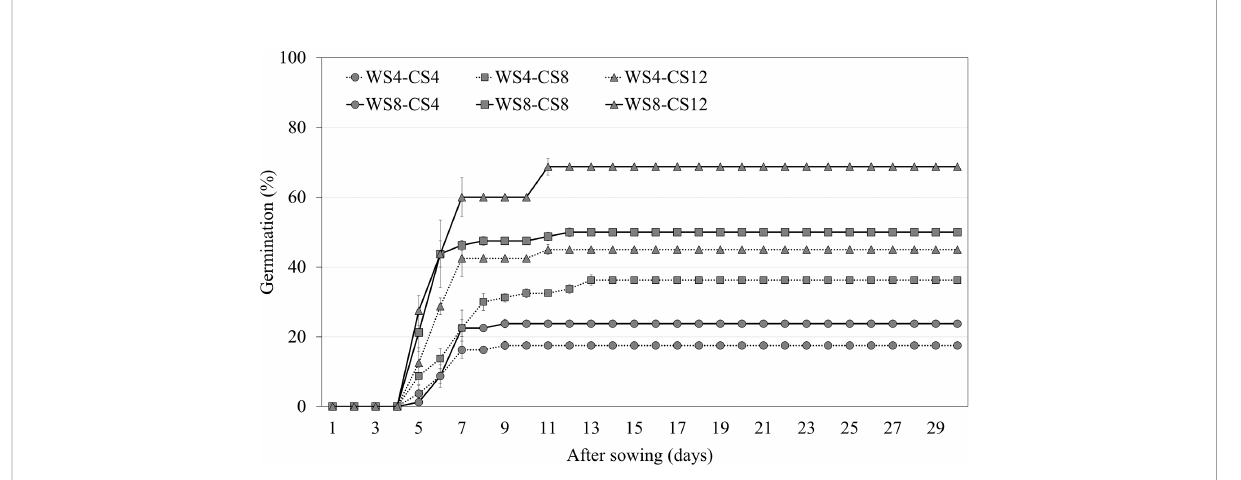
FIGURE 5 Germination of non-scari fi ed Amsonia elliptica seeds at 25/15°C after combined strati fi cation for indicated periods. WS, warm strati fi cation (15/ 10°C, 16/8 h); CS, cold (4°C). Bars represent standard error ( n =